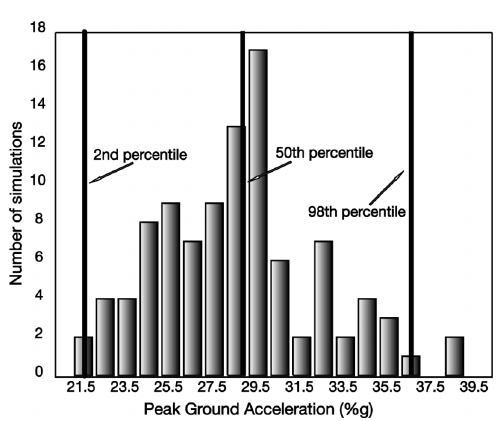
Fig. 4. Histograms of 100 simulated PGA values, obtained by Monte Carlo procedure for b -value un- certainty analysis, relative to a grid point with coor- dinates (latitude 46.5N, longitude 13E); lines indi- cate 2nd, 50th and 98th